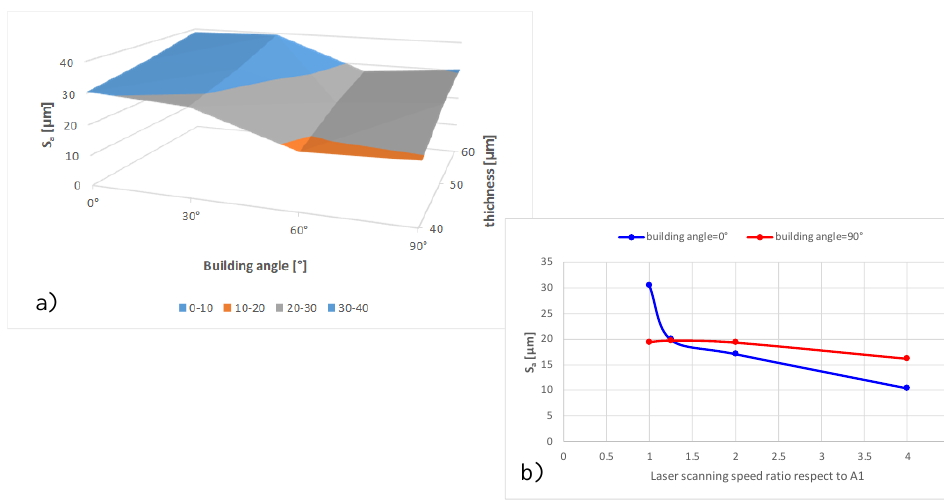
Figure 10. Key results obtained by the proposed